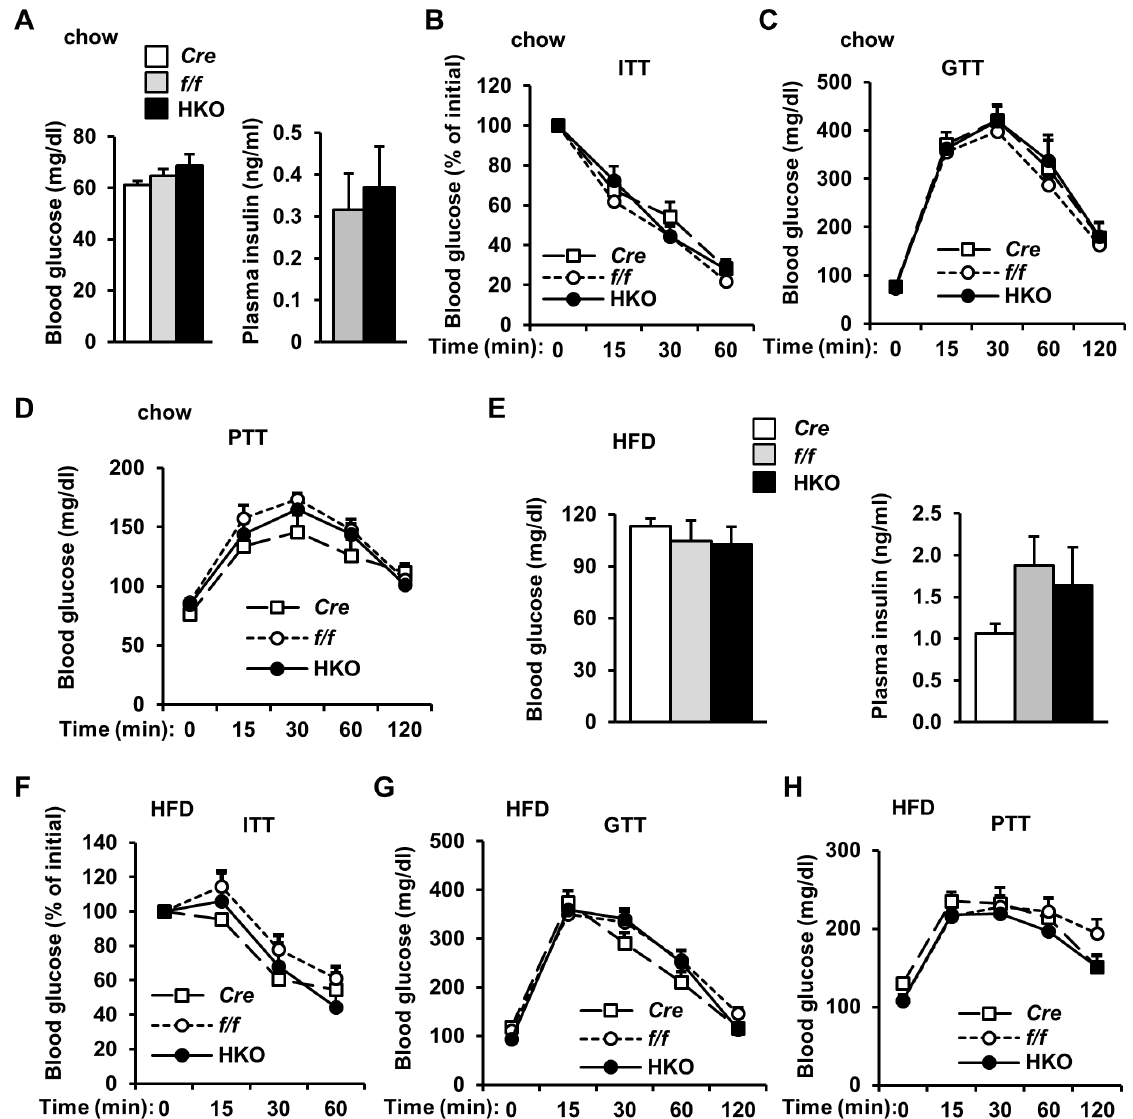
Figure 3. Hepatocyte-specific deletion of SH2B1 does not exacerbate HFD-induced insulin resistance and glucose intolerance. (A-D) Mice were fed a normal chow diet. (A) Overnight fasting blood glucose and plasma insulin levels (18 weeks of age). f/f : n=10; Cre : n=9; HKO: n=10. (B) ITT was performed on male mice at 18 weeks of age (insulin: 1 unit/kg body weight). f/f : n=10; Cre : n=7; HKO: n=10. (C) GTT was performed on male mice at 19 weeks of age (D-glucose: 2 g/kg body weight). f/f : n=10; Cre : n=7; HKO: n=10. (D) PTT was performed on mice at 19 weeks of age (pyruvate: 2 g/kg body weight). f/f : n=10; Cre : n=7; HKO: n=10. (E-H) Mice (7 weeks of age) were fed a HFD. f/f : n=9; Cre : n=6; HKO: n=8. (E) Overnight fasting blood glucose and plasma insulin (HFD for 11 weeks). (F) ITT (HFD for 11 weeks). (G) GTT (HFD for 12 weeks). D-glucose: 1 g/kg body weight. (H) PTT (HFD for 12 weeks). Data are presented as means 6 SEM. P , 0.05. doi:10.1371/journal.pone.0083269.g003 mice (Figs. 6C, D). Blood alanine aminotransferase (ALT) and alkaline phosphatase (ALP) activities are commonly used as biomarkers to estimate liver injury. MCD feeding similarly increased the activities of blood ALT and ALP in both SH2B1 f/f and HKO mice (Figs. 6E, F). Blood bilirubin levels and liver TAG content were also similar between SH2B1 f/f and HKO mice (Figs. 6G, H). These data indicate that hepatic SH2B1 is not required for the maintenance of liver integrity and protection against liver injury.